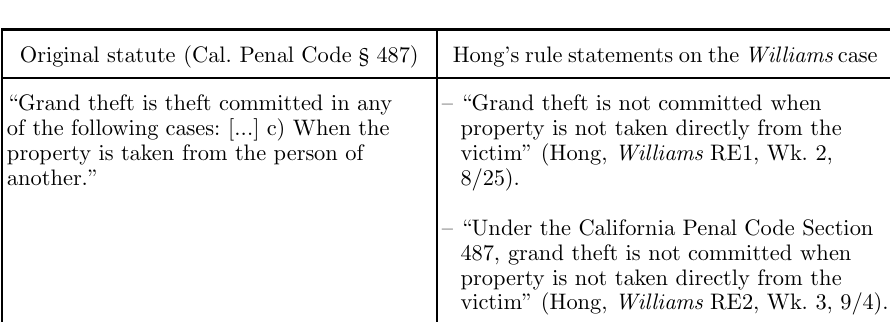
Comparison of California grand theft person statute